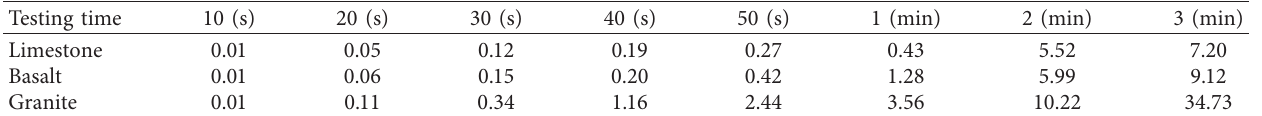
Table 4: Stripping rate of modified asphalt in boiling test W